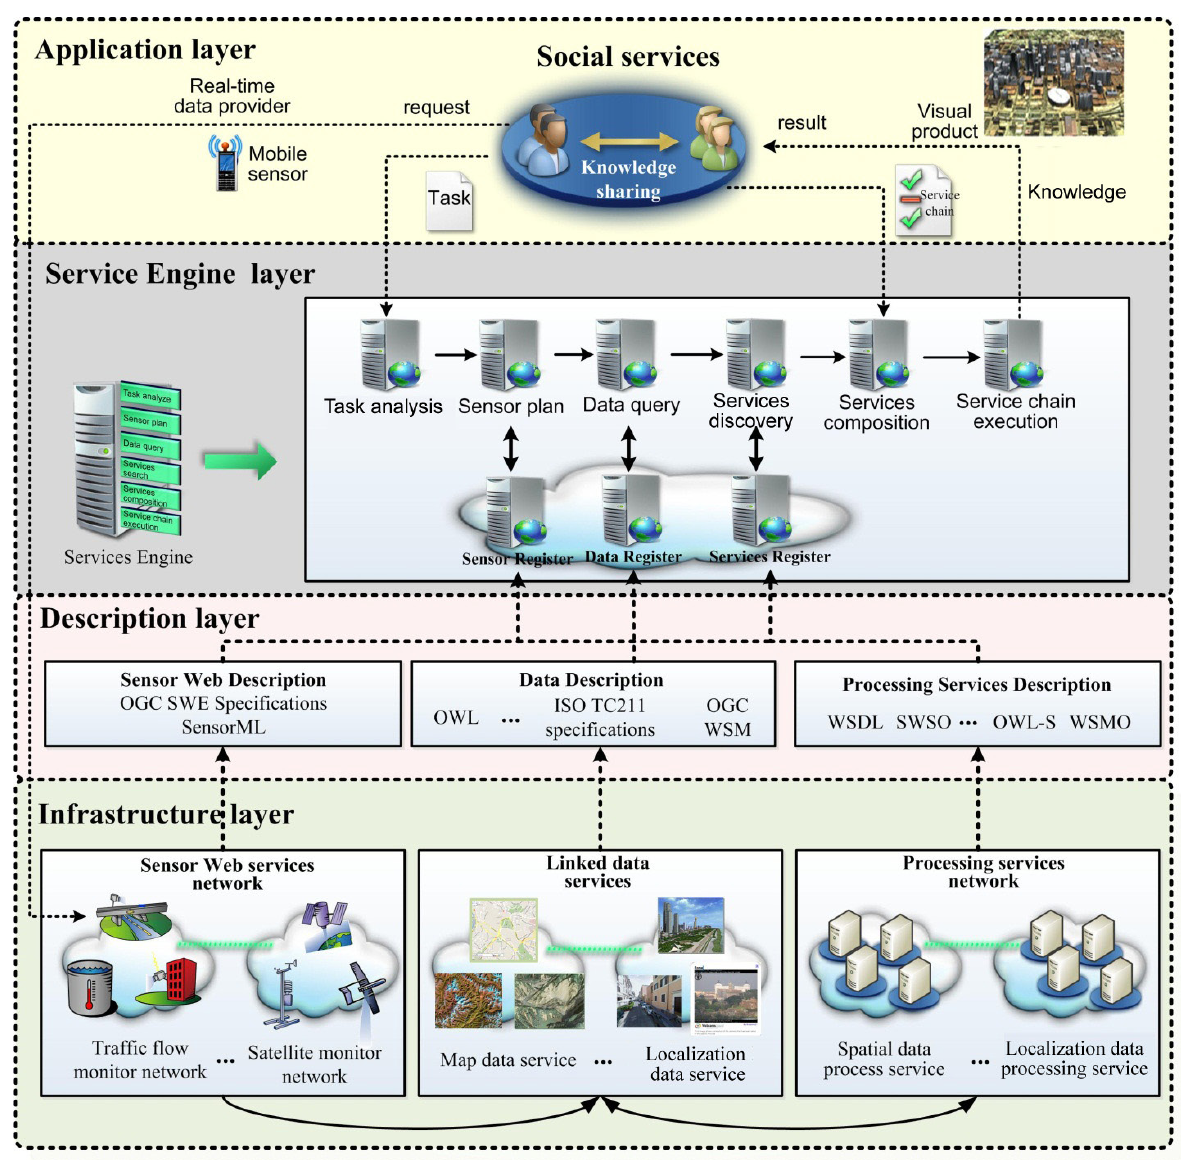
Figure 5. The service-oriented architecture for